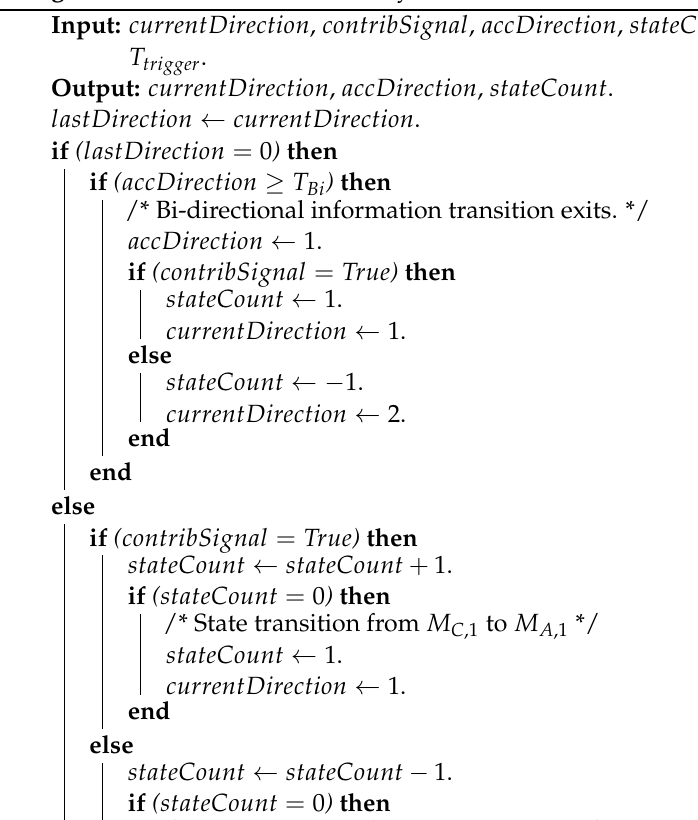
Algorithm 4: The Mechanism of System State